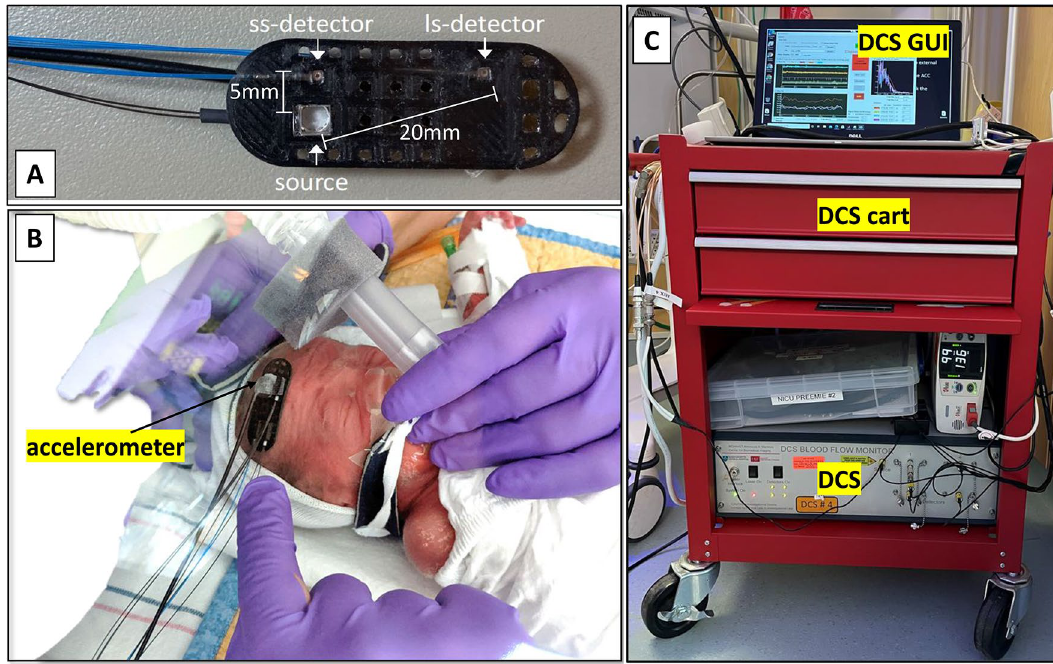
Figure 1. The DCS optical sensor included 5 mm/short- and 20 mm/long-separation channels ( A ) and an accelerometer ( B ). The sensor was attached to the infant’s head with a hydrogel to ensure skin integrity during the long monitoring sessions and was covered by a continuous positive airway pressure (CPAP) hat ( B ). The DCS cart was equipped with a DCS device and a computer running the DCS graphical user interface ( C ). Arterial blood pressure measurements, when available, were co-recorded through an auxiliary port on the DCS device. (For B, the informed consent was obtained from the parent for publication of identifying images in an online open-access